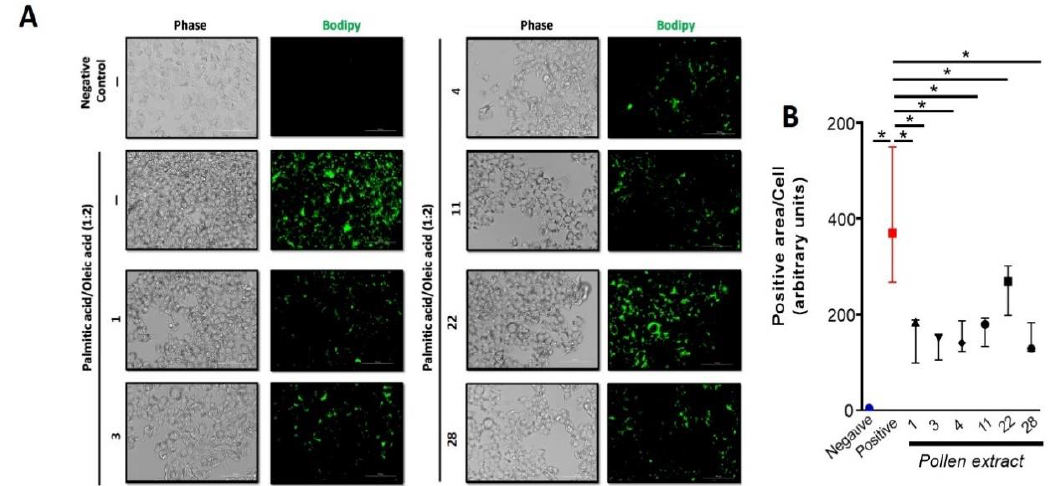
Figure 3. Pollen extracts reduce steatosis in an in vitro cell model. ( A ) Bodipy lipid staining in Hepa1-6 cells line treated with ethanol extracts of pollen at a concentration of 0.1 mg/mL 1, 3, 4, 11, 22, and 28. The cells were pre-treated with pollen extracts for 2 h, prior to loading with lipids (palmitic/oleic acid) for an additional 24 h. ( B ) The quantifications are in arbitrary units to estimate the bodipy lipid staining in Hepa1-6 line treated with ethanol extracts of pollen. Data are shown as median ± first quartile and third quartile ( n = 3). Mann-Whitney statistical test was performed between the positive control and different pollen extract. The asterisks (*) represent statistically significant differences ( p < 0.05).